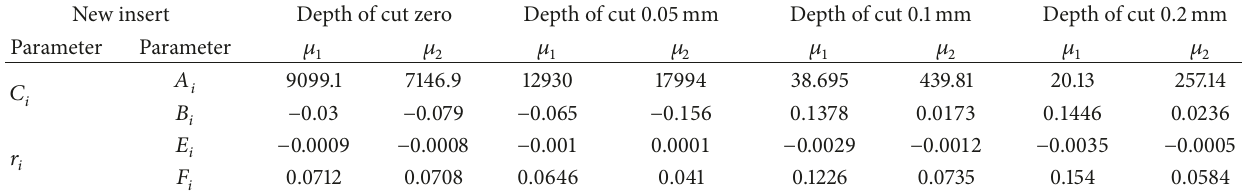
Table 5: Values of the parameter’s constants of the friction coefficient functions, in the case of the new